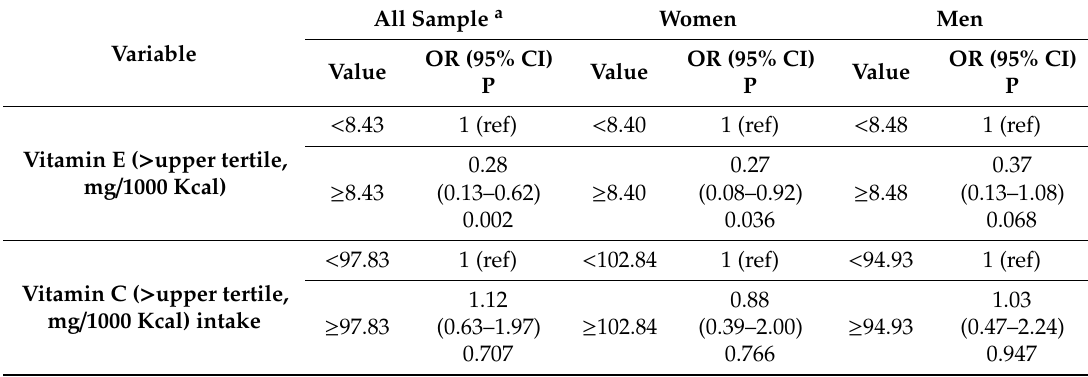
Table 3. Multivariate association of vitamins E and C dietary intake and high MDA levels (above the sample